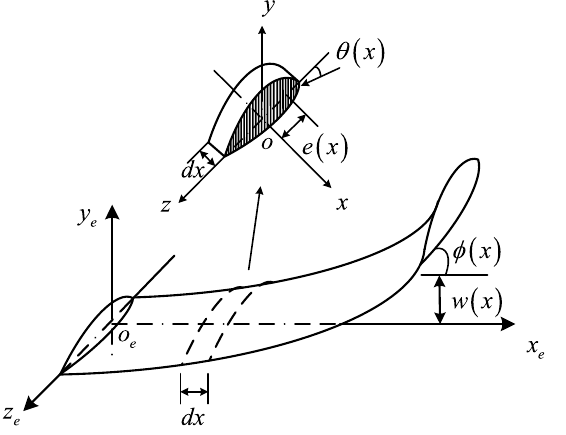
Figure 1. Definition of coordinate system.